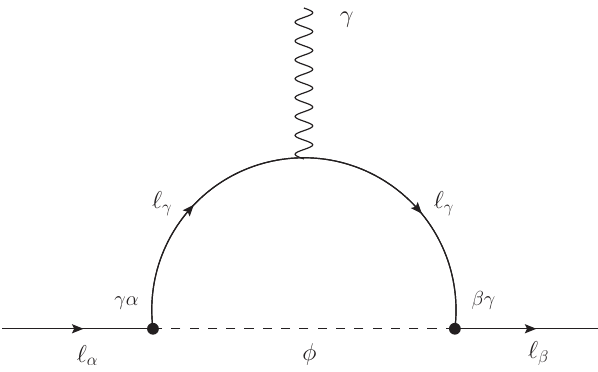
Figure 2 . One-loop Feynman diagram contributing to the process ‘ α → ‘ β γ described by the effective Lagrangian in eq. (2.1). The flavor indices of the couplings contributing to the diagram have been specified in the